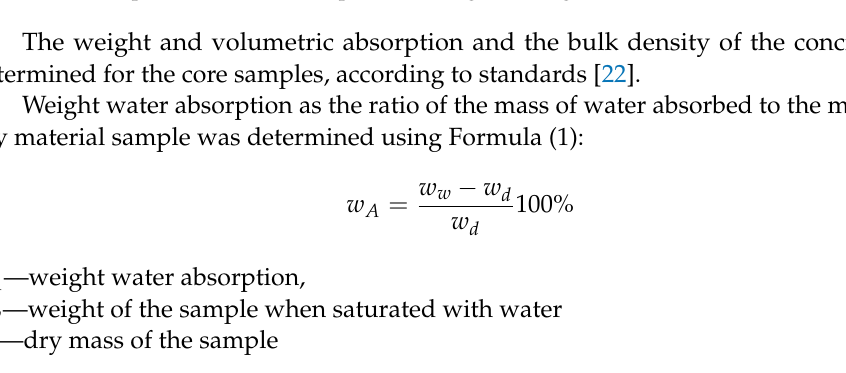
Figure 11. Example of a concrete sample in a strength-testing machine.